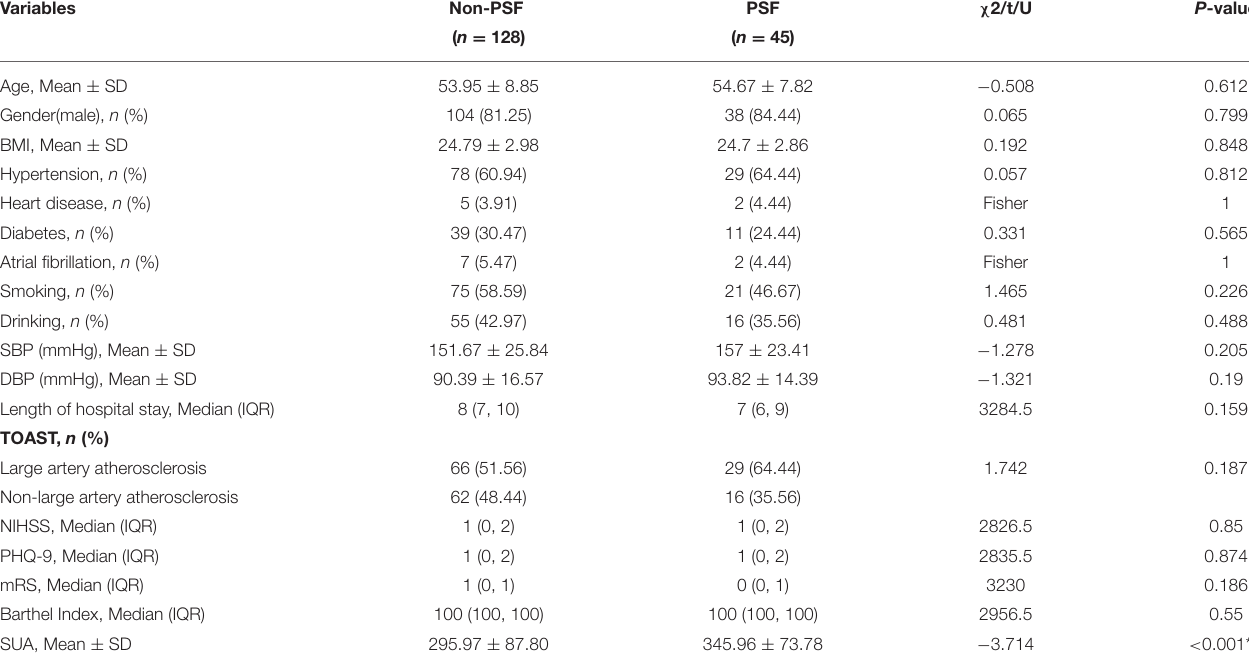
TABLE 1 | Comparison of characteristics between the PSF and Non-PSF groups.